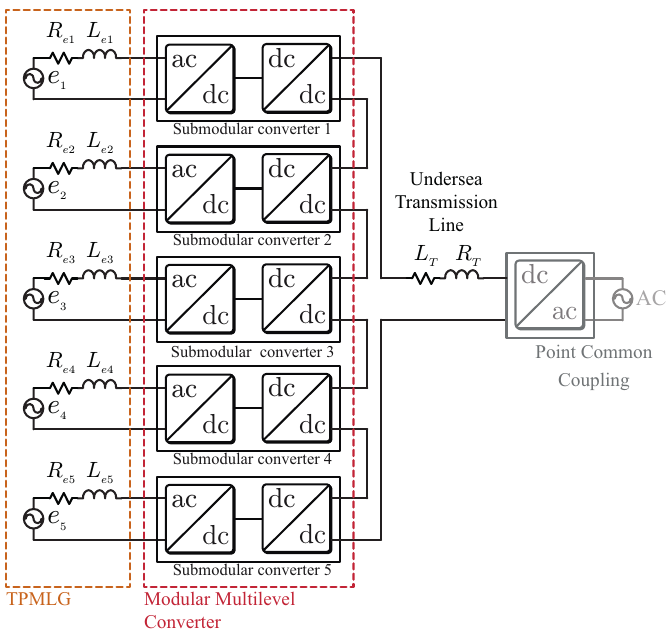
Figure 5. Modular inverter schematic with grid connections.